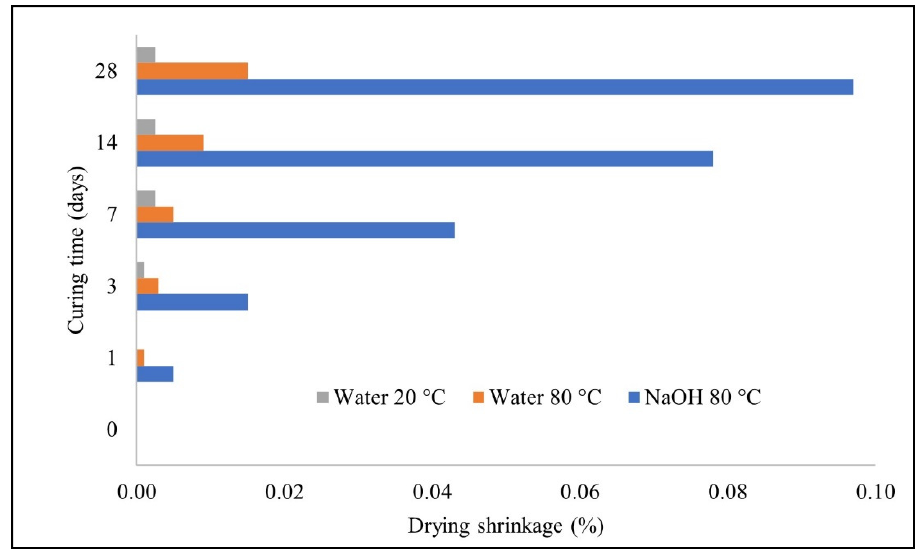
Figure 9. Drying shrinkage of dry-mixed cement mortar containing MSWI-BA, subjected to different curing regimes. Redrawn from [44].